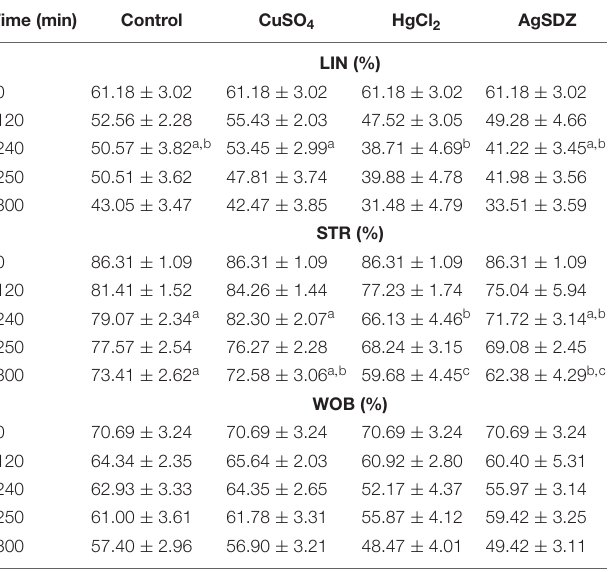
TABLE 2 | Secondary sperm kinetics parameters.